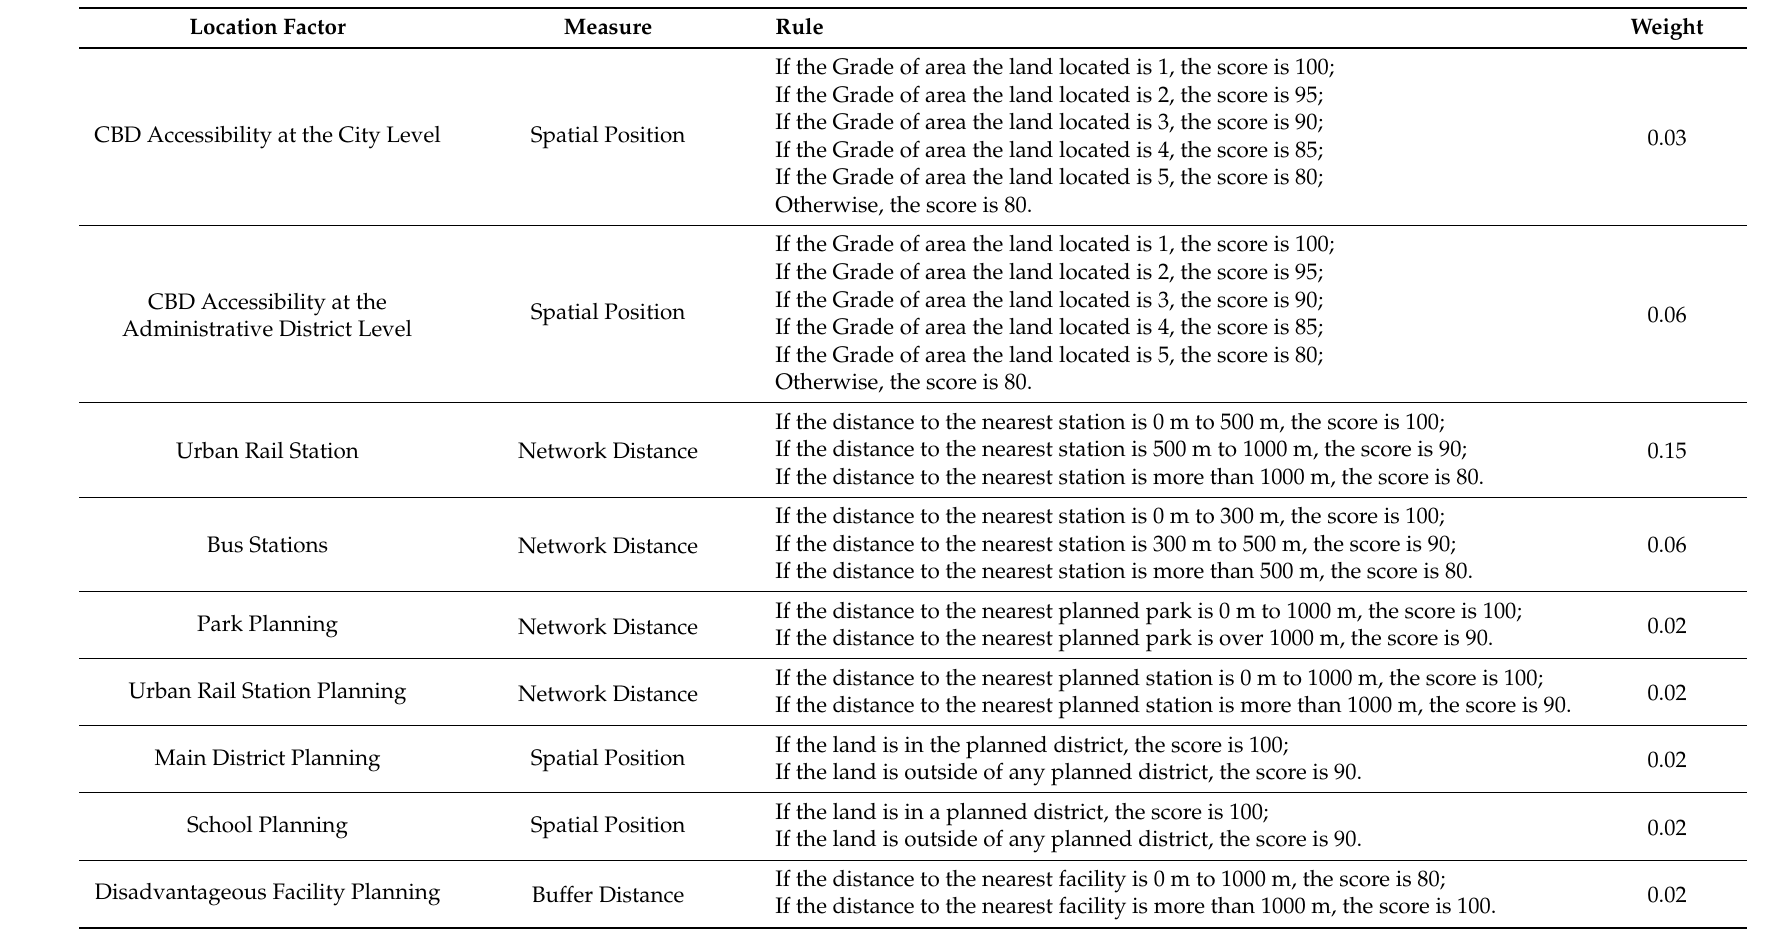
Table 1. Location factors, as confirmed by